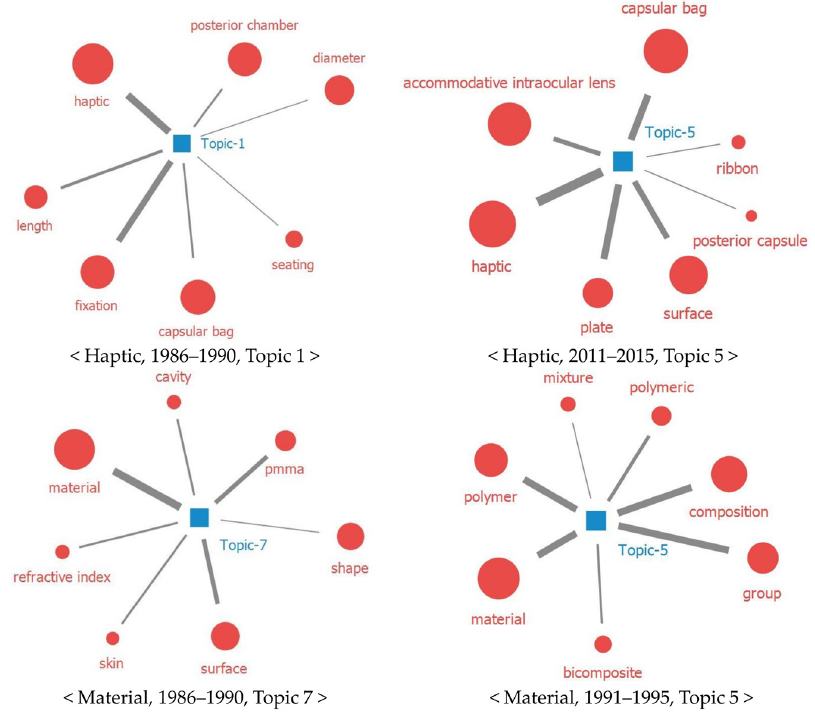
Figure 3. Topic modeling results for haptic and material among the 4 IOL technologies.